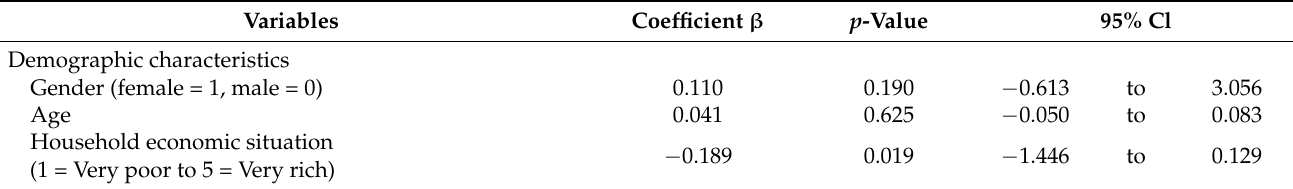
Table 5. Multiple regression analysis results with CES-D as the dependent variable ( n =